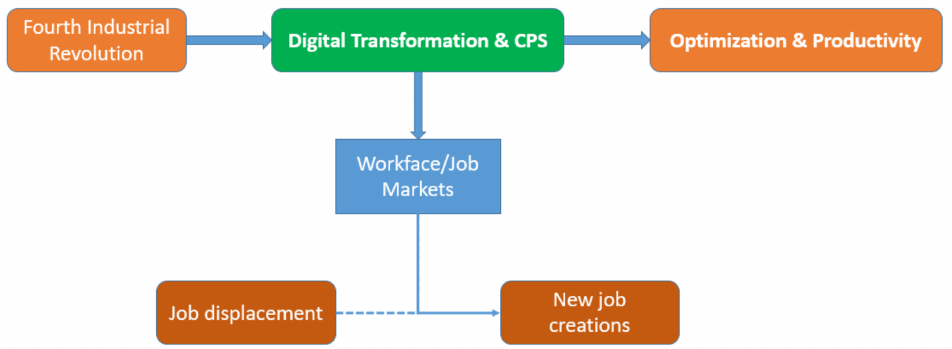
Figure 2. Fourth Industrial Revolution and